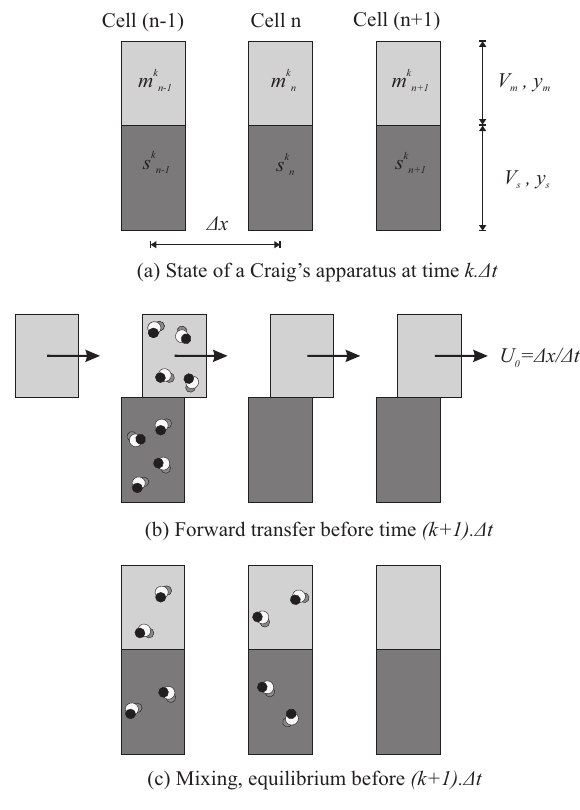
Figure 2. Mechanism at work in Craig’s machine ( a ). Between the instant k and ( k + 1 ) , all the MP volumes (light grey) are transferred to the next cell. SP volumes (dark grey) don’t move. Injection is typically performed in the first cell. Few solute molecules are represented and can be followed ( b ). During the same time interval, all the cells are agitated simultaneously to reach the partition equilibrium s k n = K d m k ( c ). The effective speed of MP results from the space interval between the cells and the time required for transfer/mixing/equilibrium that is U 0 = ∆ x / ∆ t . Then, pure MP feeds the first cell at each